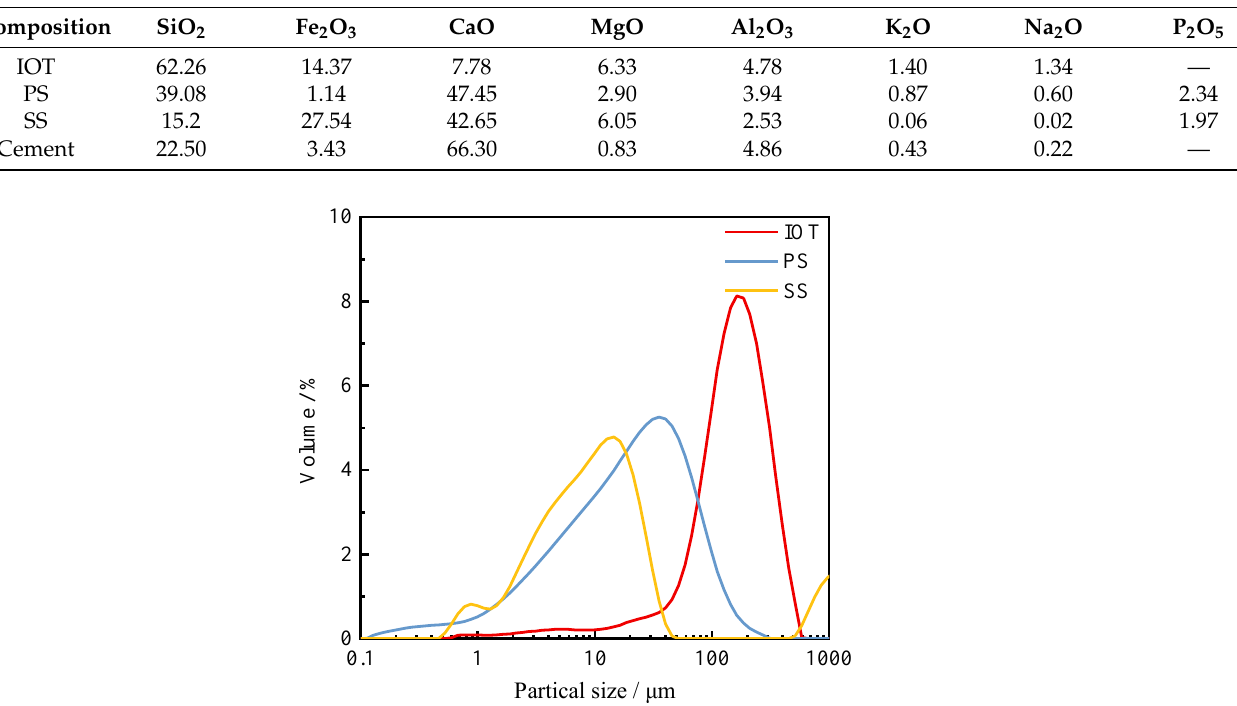
Table 1. Chemical compositions of IOTs, PS, steel slag, and cement (w/%).